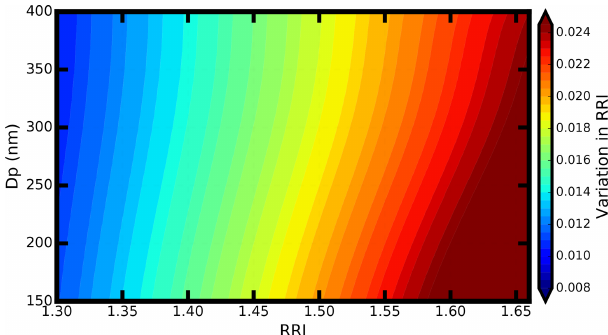
Figure 6. The variation in RRI for different kinds of aerosols that have different diameters and a different